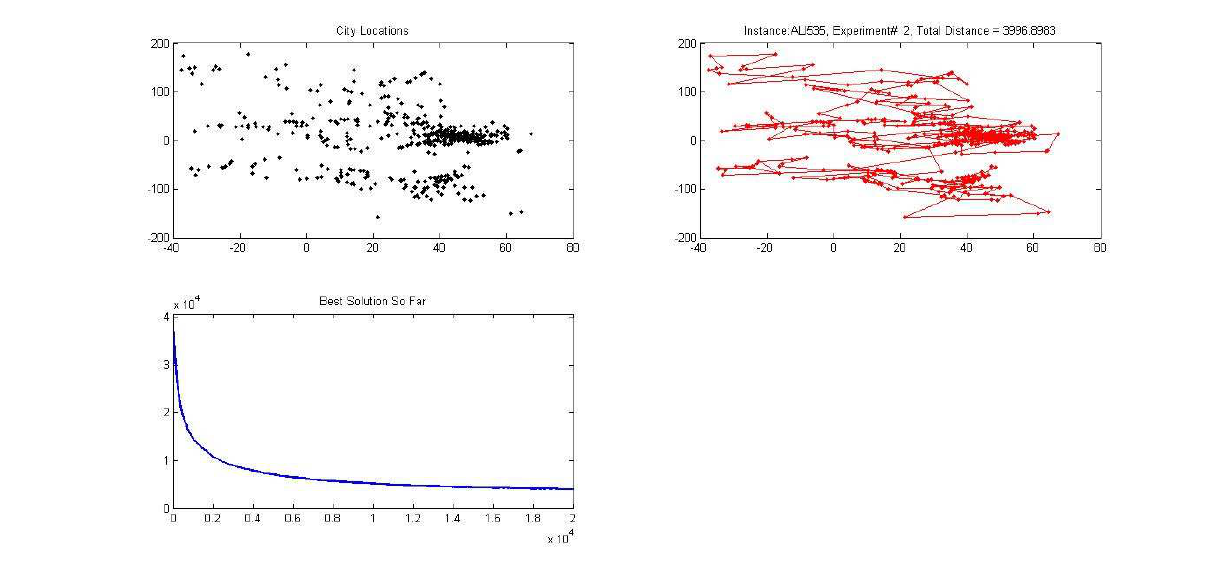
Figure 3. Graph illustrating one of the experiments on the ali535 instance of TSP (containing 535 cities) solved by the proposed BCSO algorithm. The graph depicts the city location, total distance and best solution